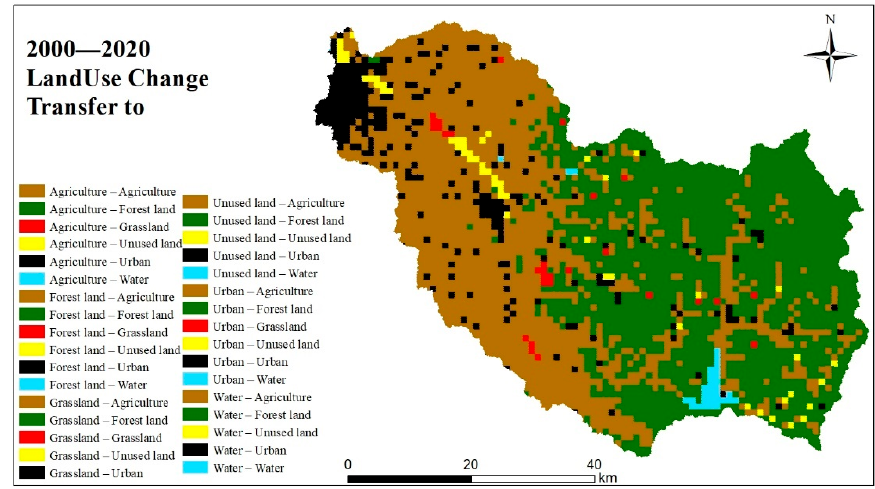
Figure 13. Land use change, 2000–2020. (Here are two different diagrams. The land use transferred from the previous image will be transferred to a different land use, which can be distinguished by color).